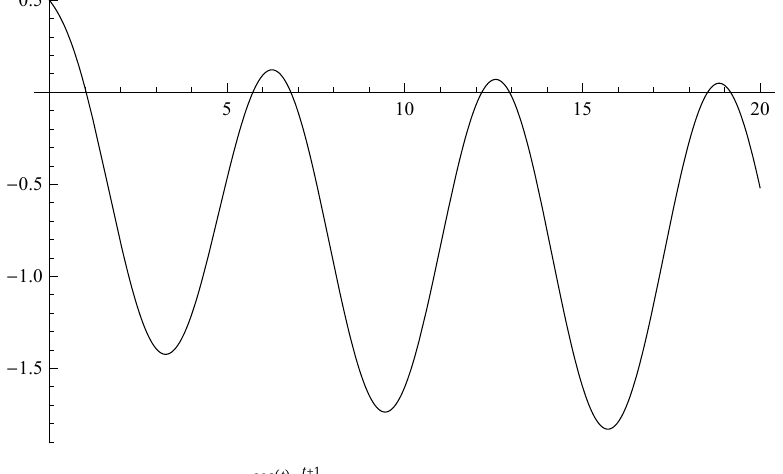
t +1 . t +2 2− sin ( t )